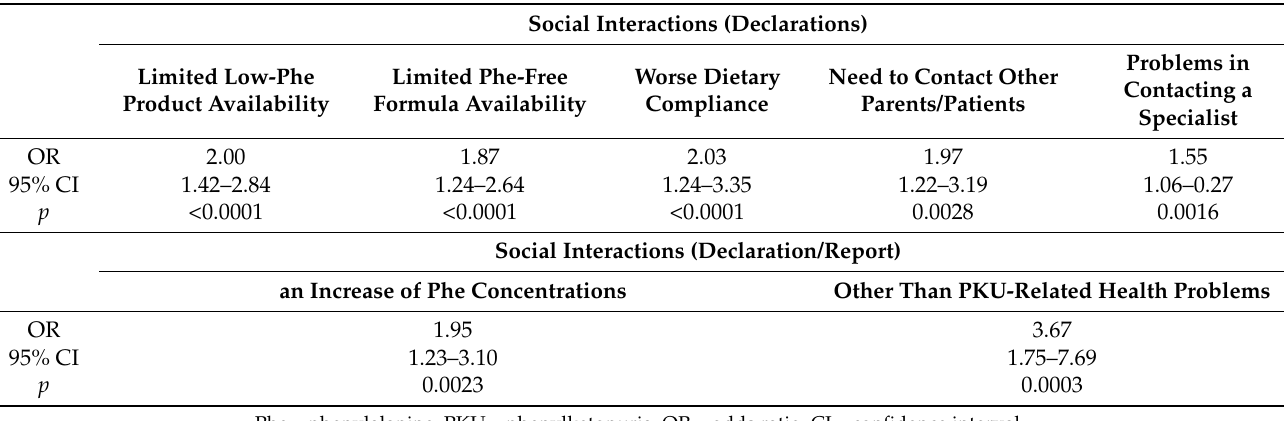
Table 5. Comparison of patients’ frequency of reporting high stress vs. low-intermediate stress intensity depending on social